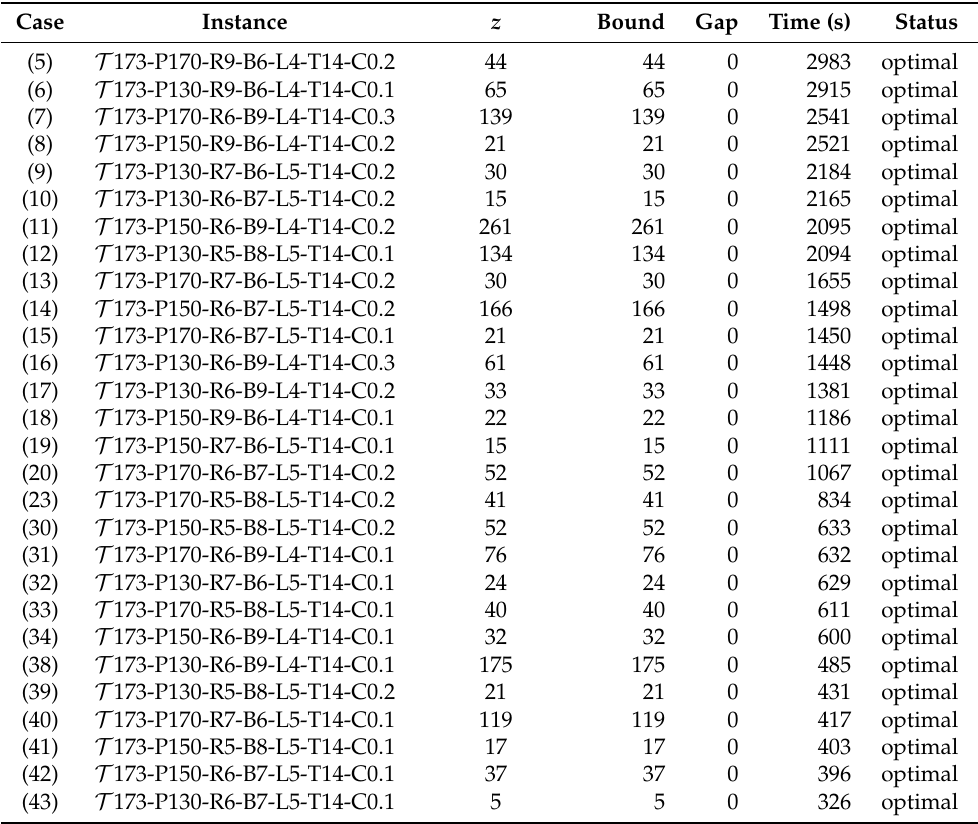
Table 4. Gurobi results for optimally solved problem